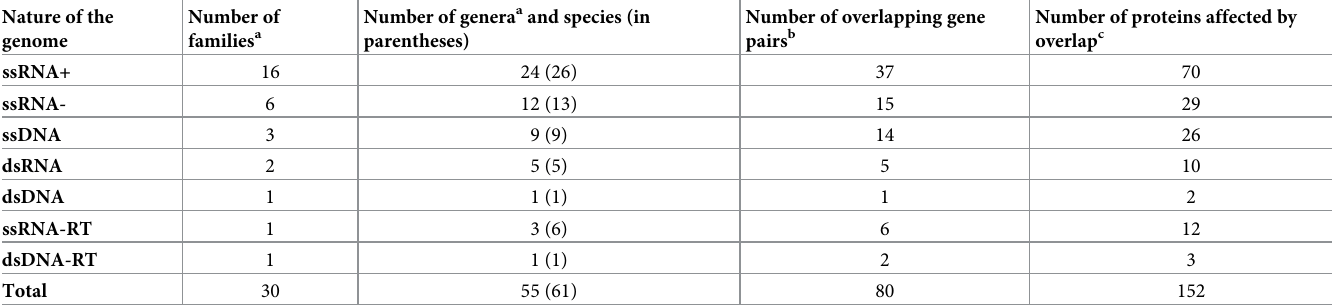
Table 1. General properties of the overlapping gene